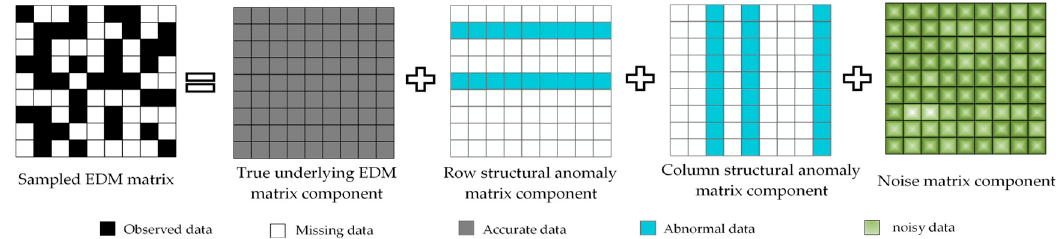
Figure 1. Pipeline of node localization for Wireless Sensor Networks (WSNs) in complex environments.